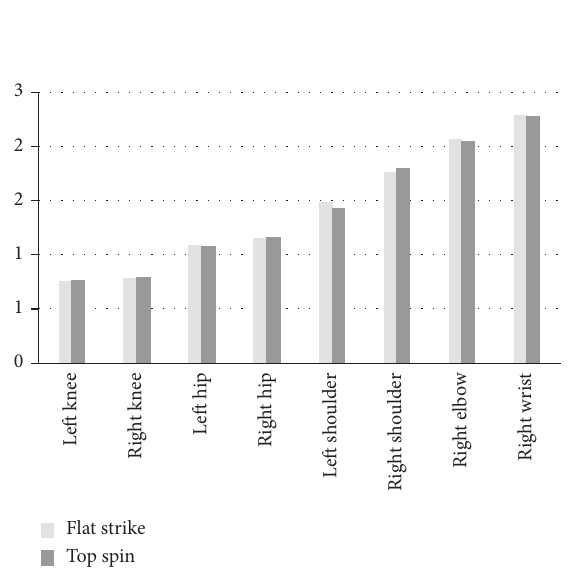
Figure 11: Comparison of spatial characteristics of the lowest point of the shoulder joint in the racket stage. Table 6: Comparison table of the height of the hitting point of the flat strike and the top spin (unit: m).